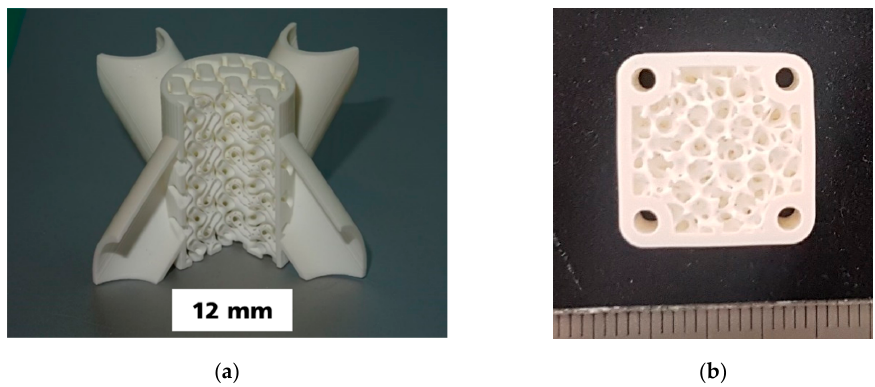
Figure 9. Sintered alumina components manufactured by CerAM VPP: Sliced version of the reactor component ( a ), ceramic component with graded porosity, and pore size distribution inside ( b ).